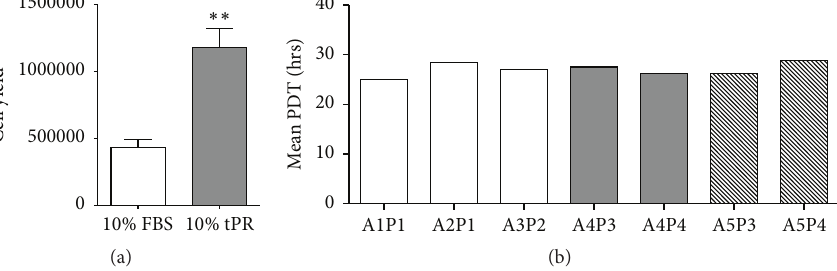
Figure 3: The effects of tPR on the growth of passage 1 ASCs. (a) 100,000 passage 0 ASCs were passaged and grown for 4 days in either 10% FBS or 10% tPR. Starting from an initial plating of 100,000 cells, tPR supplemented media displayed a significantly higher cell yield after four days ( 𝑃 < 0.01 ). (b) Little variability was seen in the population doubling times (PDT) in various ASC lines (A1–A5) exposed to different tPR preps (P1–P4). In particular, cell lines A4 and A5 were cultured in both P3 and tP4 PR preps and no significant differences in growth were